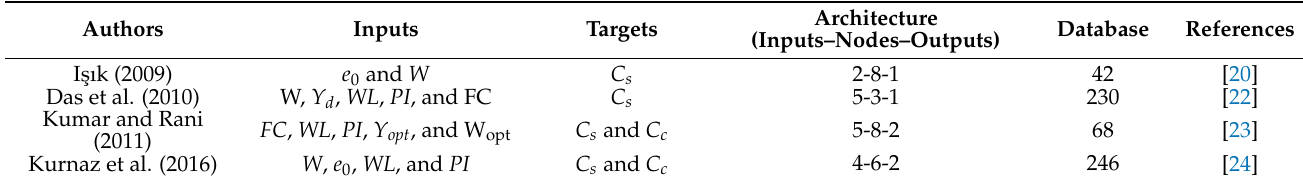
Table 2. Proposed ANN models in the literature to estimate the swelling index C s